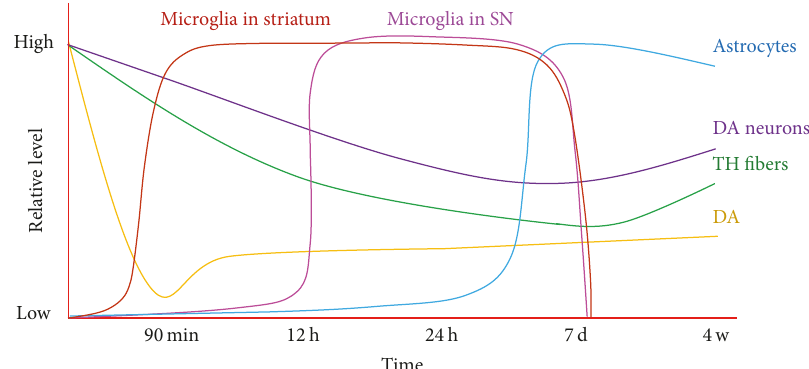
Figure 3: Dynamic changes in the nigrostriatal pathway in the acute MPTP mouse model of Parkinson’s disease.